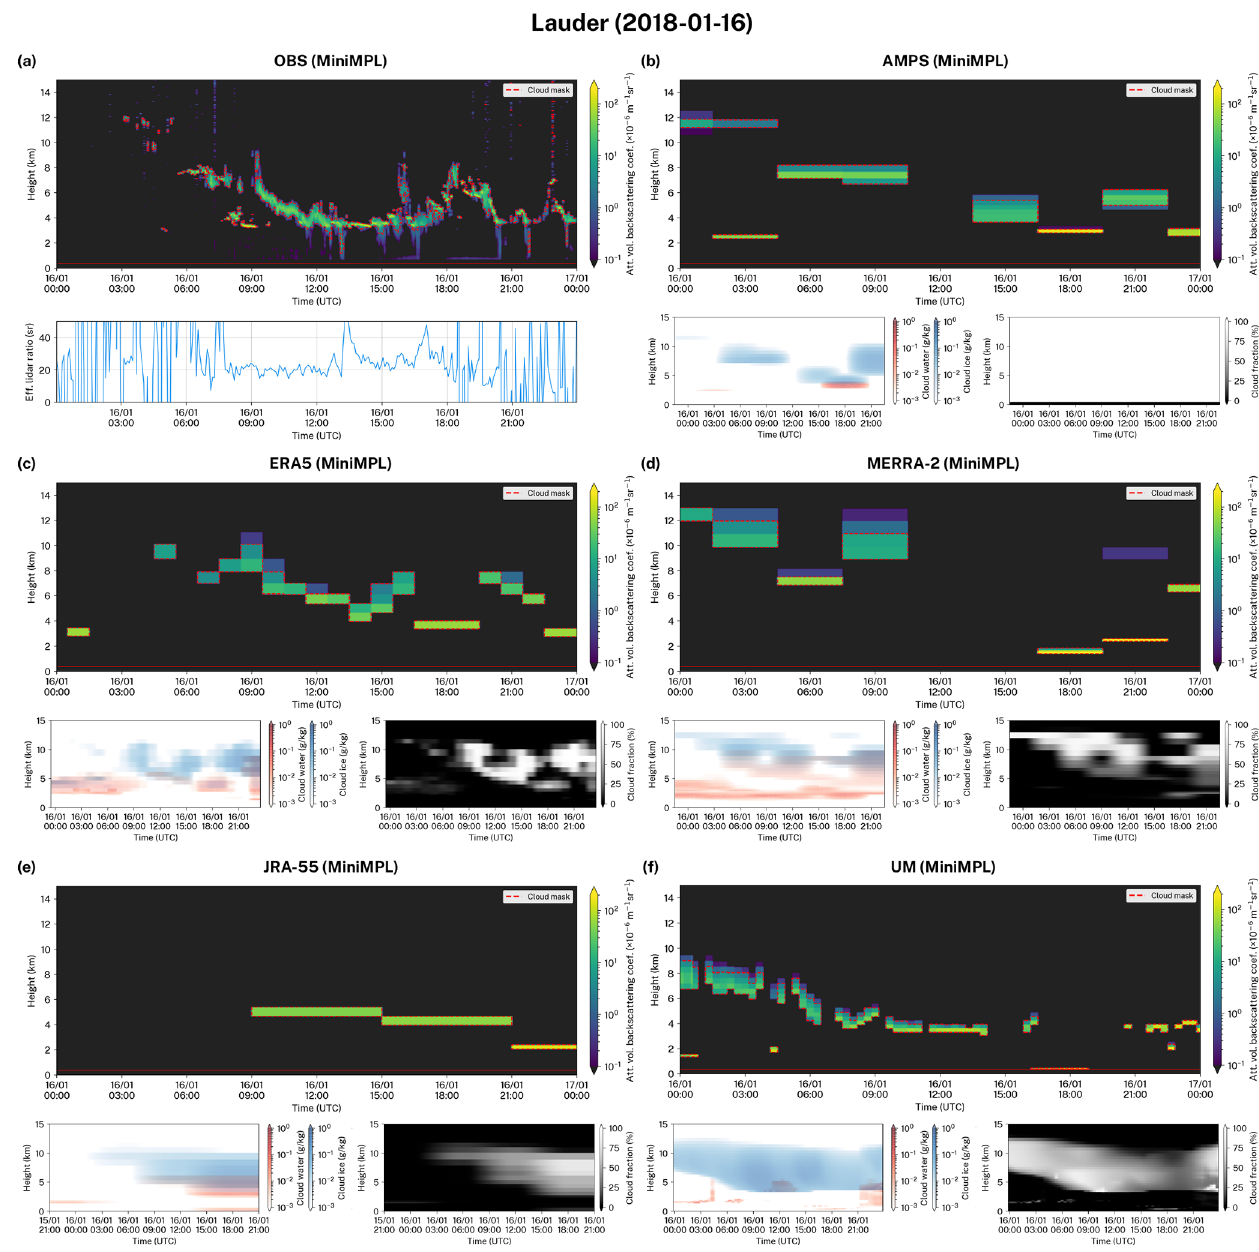
Figure 5. The same as Fig. 4 but for the